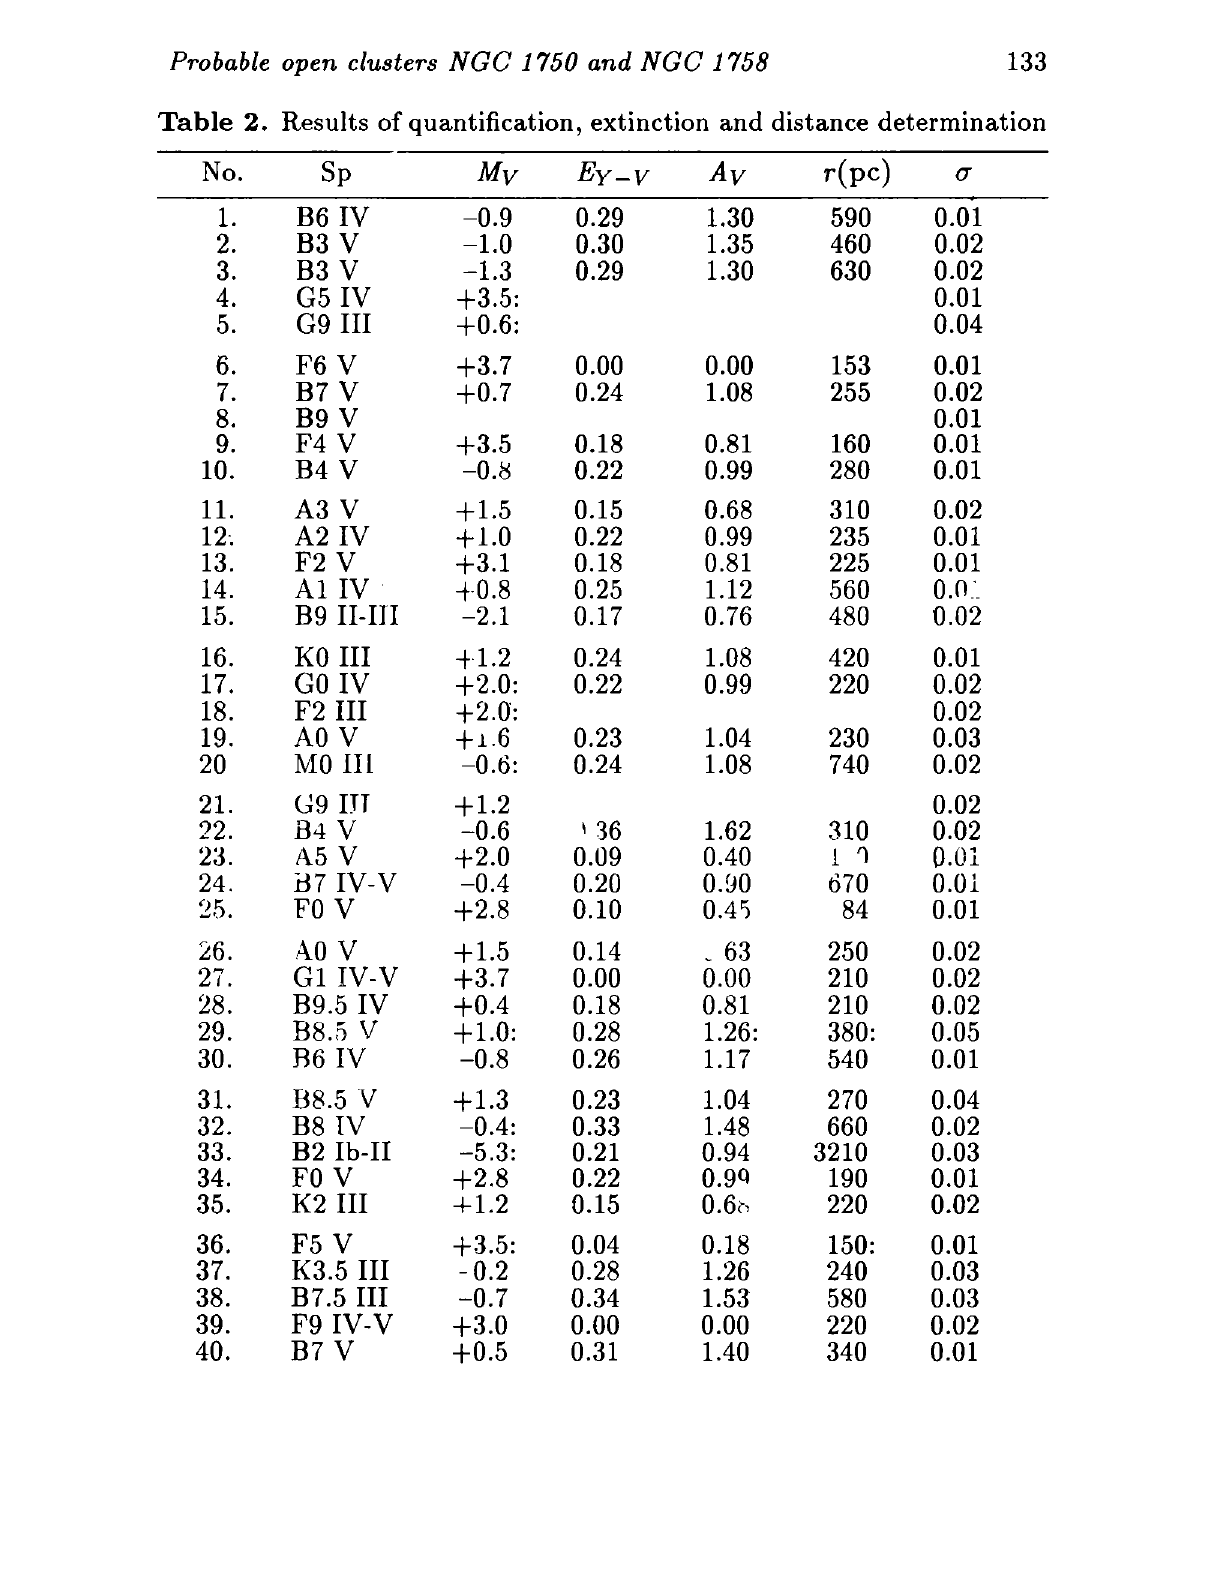
Table 2. Results of quantification, extinction and distance